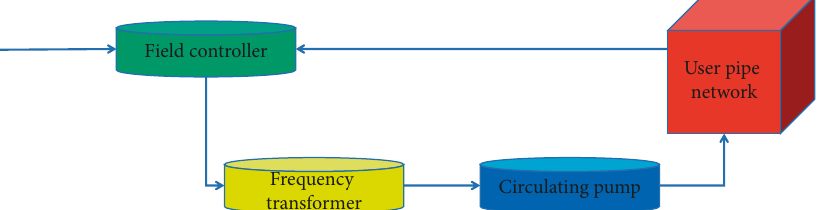
Figure 3: Automatic regulation of user pipe network heating.